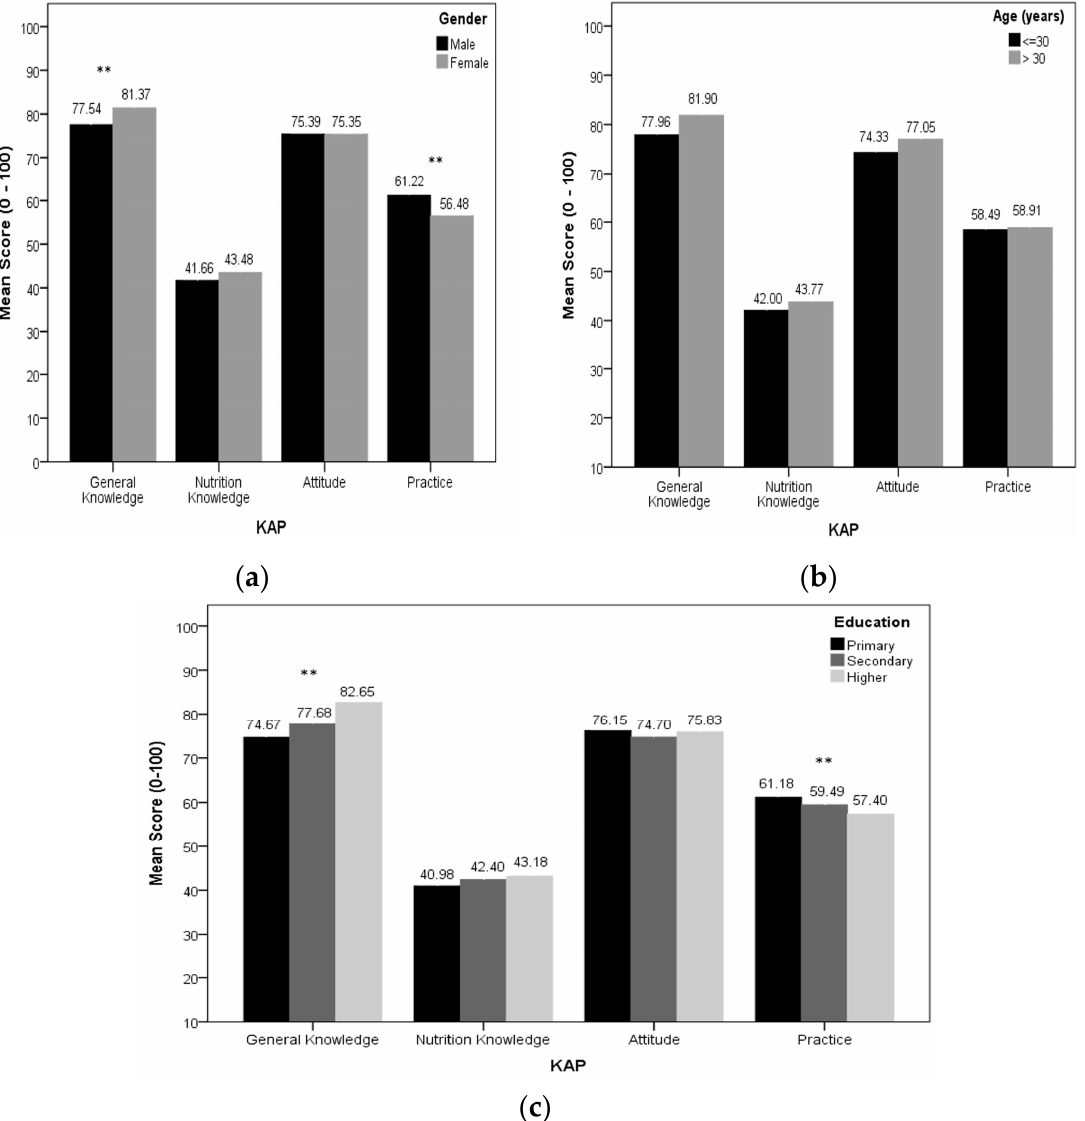
Figure 3. Mean comparison of D-KAP-38 sub-scales for sex ( a ); age ( b ); and education ( c ) groups (** p < 0.01).